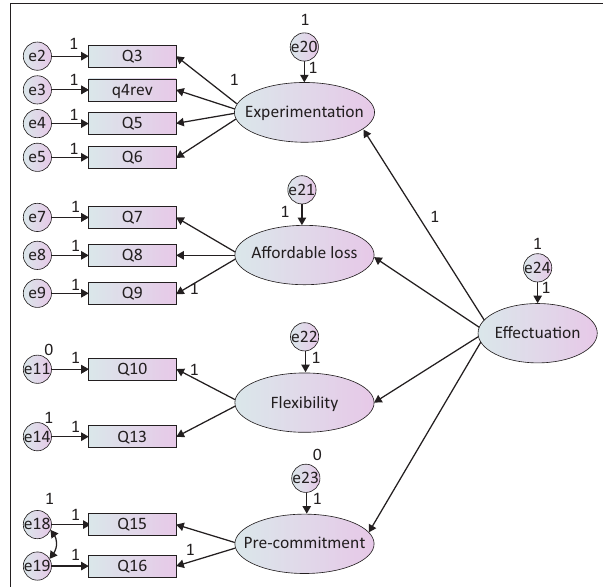
FIGURE 2: Structural equation modelling – relationship between effectuation constructs and financial business growth. FIGURE 3: Effectuation second-order measurement